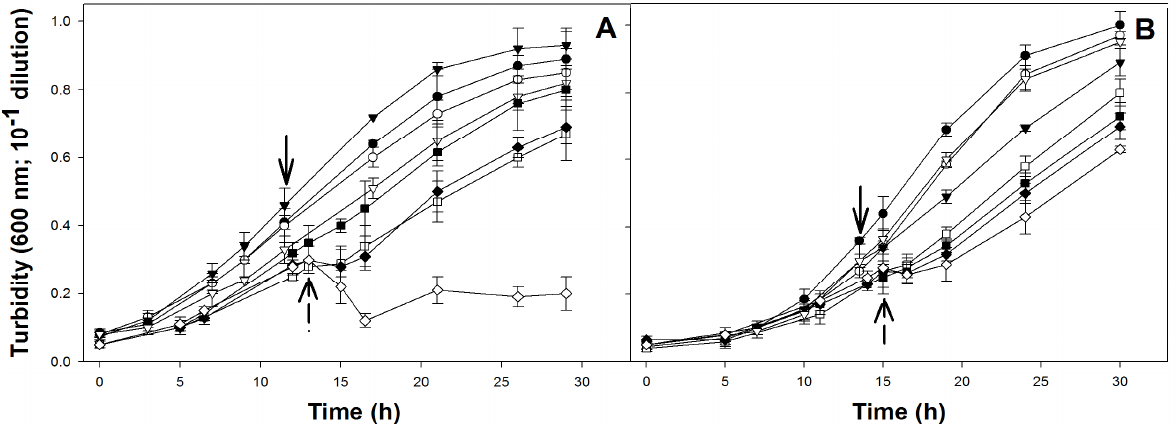
FIGURE 3. Cells of the w-t that had been grown on mannitol (A) and benzene (B) were challenged with increasing liquid concentrations of benzene — 0.05% ( (cid:1) ), 0.08% ( (cid:2) ), 0.10% ( (cid:1) ), 0.15% ( (cid:2) ), 0.20% ( (cid:3) ), 0.25% ( (cid:4) ), 0.30% ( (cid:5) ), and 0.35% ( (cid:6) ). The arrows denote the time when benzene was added (solid arrow for 0.05–0.15%; dotted arrow for 0.20–0.35%). Where SD error bars are not shown, it is because they were smaller than the